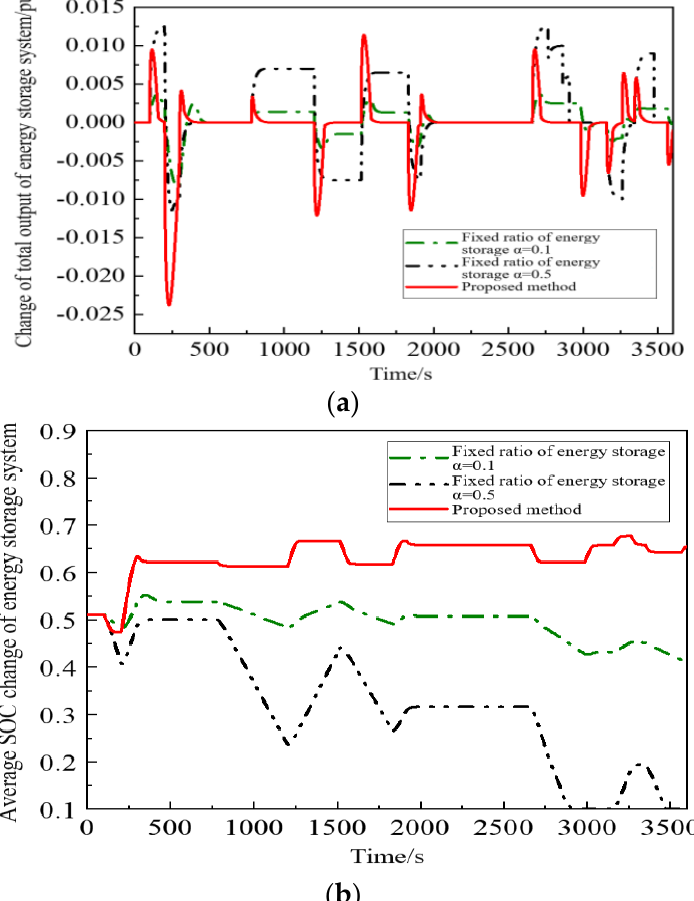
Figure 6. Variation of total output and average SOC of energy storage system under continuous disturbance. ( a ) Changes in the total output of the energy storage system. ( b ) Average SOC change of energy storage system.